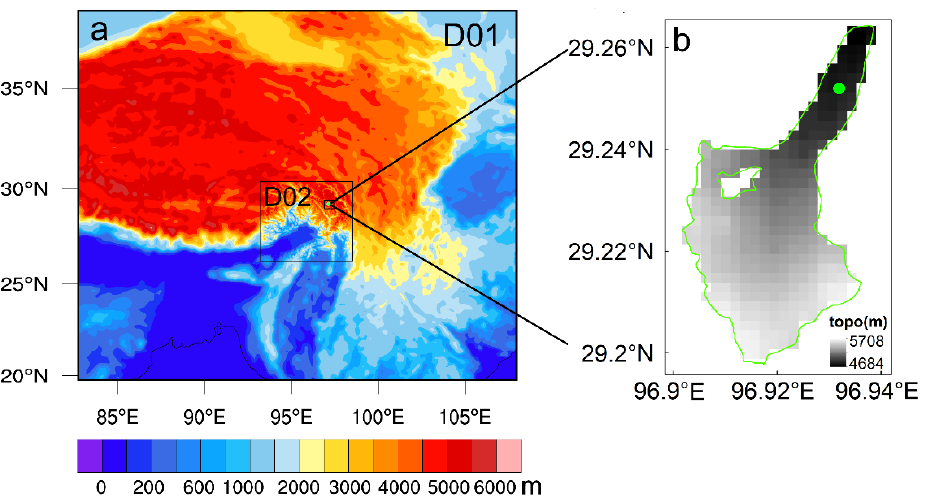
Figure 1. ( a ) WRF domains and model topography. ( b ) Terrain elevation from the WRF model, shaded in units of meters with the green line denoting the glacier boundary and the green solid circle denoting the observation site in the ablation zone of Parlung No. 4 Glacier.